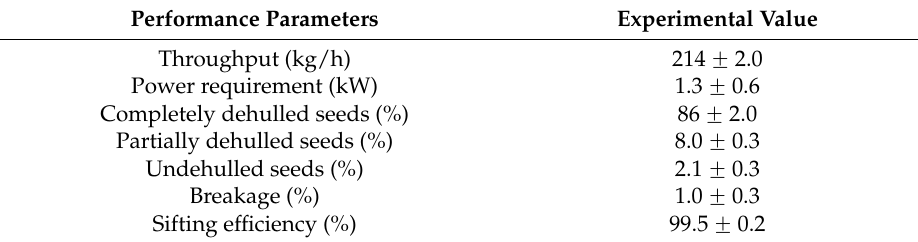
Table 1. Off-design performance of the prototyped breadfruit dehuller 1